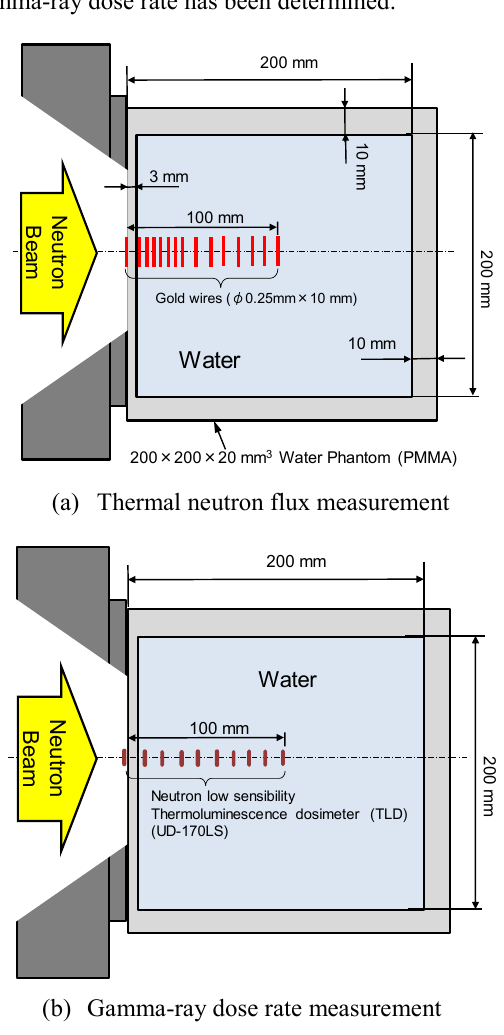
Fig. 3 Experimental conditions for the water phantom irradiation to measure the distributions for (a) thermal neutron flux and (b) gamma-ray dose